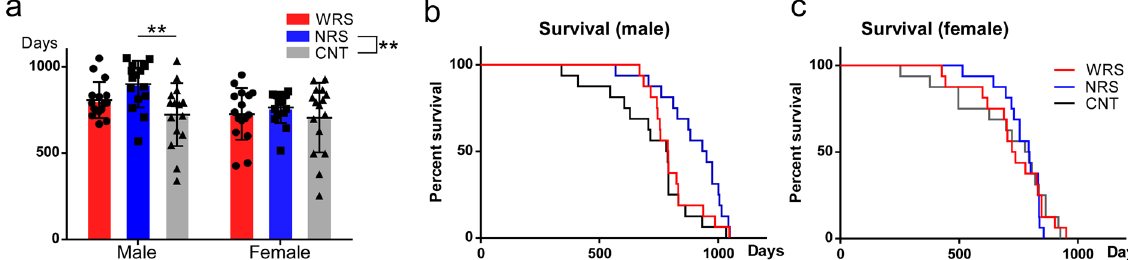
Figure 3. Lifespans of male and females for all sound conditions: WRS (wide range of sounds), NRS (narrow range of sounds), and CNT (control). ( a ) Average lifespans of male and females for all sound conditions. Lifespan survival curves for ( b ) males and ( c ) females. Error bars indicate the standard